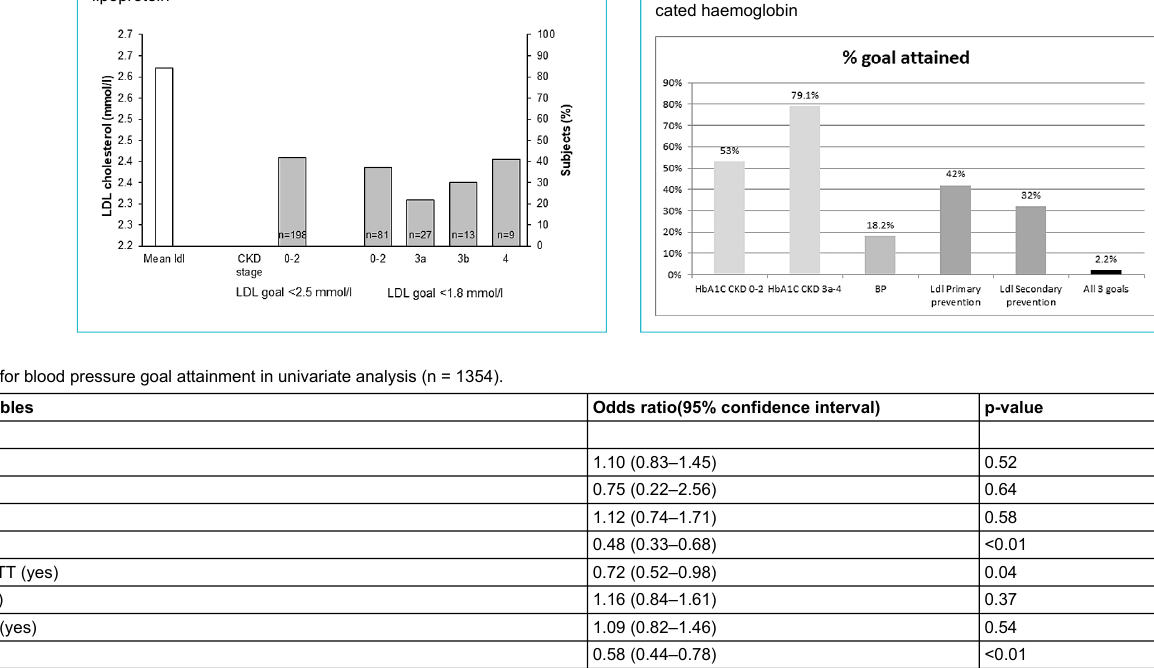
Figure 5: Percentage of patients reaching glycated haemoglobin, blood pressure and low-density lipoprotein-cholesterol goals.BP =